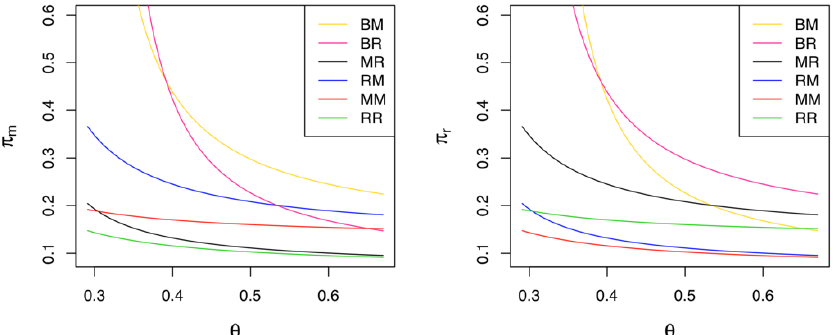
Figure 8. Comparisons of profits among all six models.